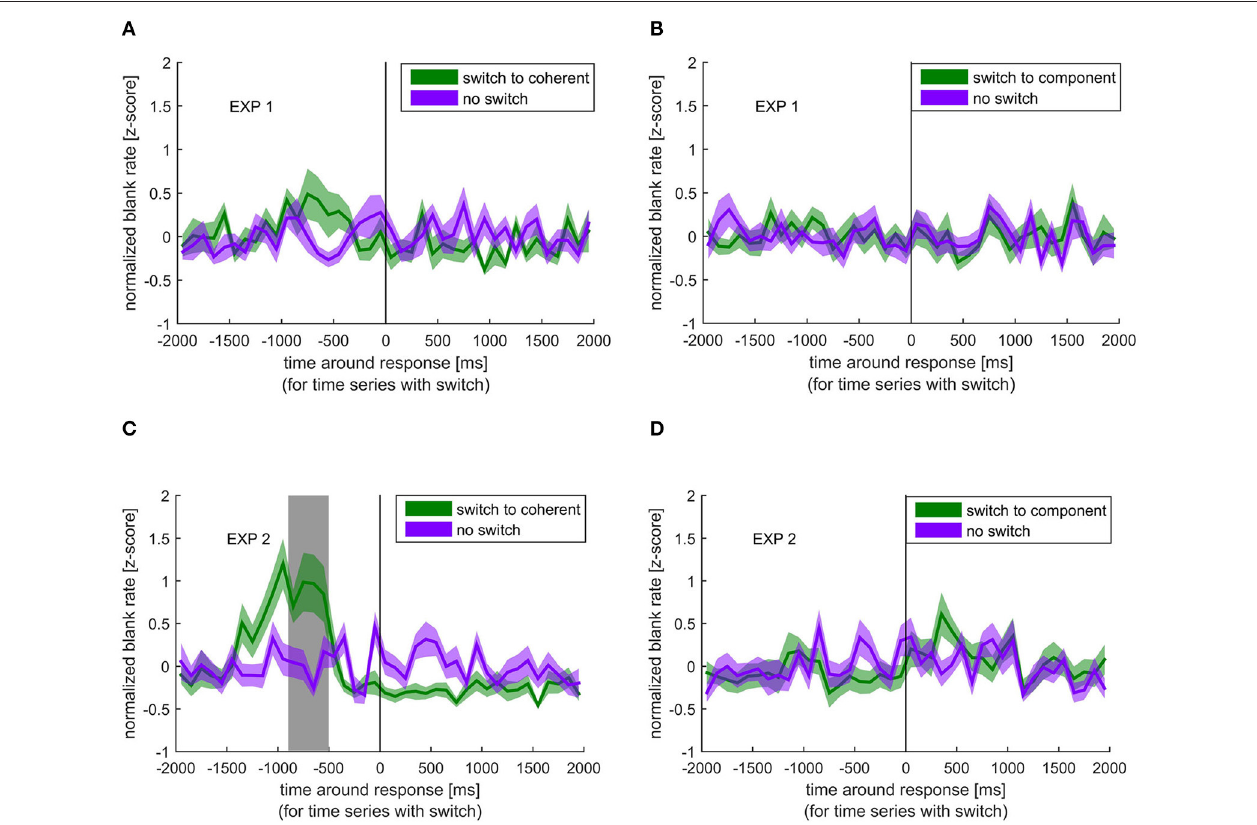
FIGURE 3 | Normalized blank rate around the response indicating a perceptual switch (green) compared with the normalized blank rate during no switch (purple). Colored lines and ribbons represent mean ± standard error of the mean (SEM). Vertical shaded area marks significant time points revealed by the non-parametrical statistical test procedure described by Maris and Oostenveld (2007). (A) Switch to coherent motion in experiment 1. (B) Switch to component motion in experiment 1. (C) Switch to coherent motion in experiment 2. (D) Switch to component motion in experiment